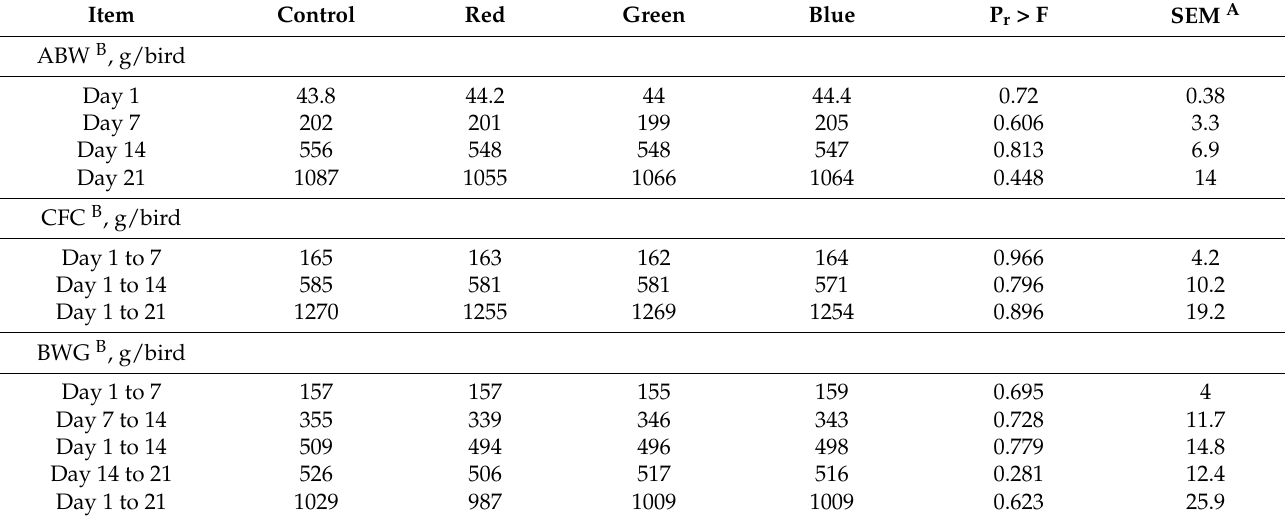
Table 3. Influence of Control (basal diet only), Red, Green, and Blue Feed Colors on Average Body Weight, Cumulative Feed Consumption, Body Weight Gain, and Adjusted Feed Conversion Ratio of Broilers from 1 to 21 Days of Age (Least Squares Means) (Trial